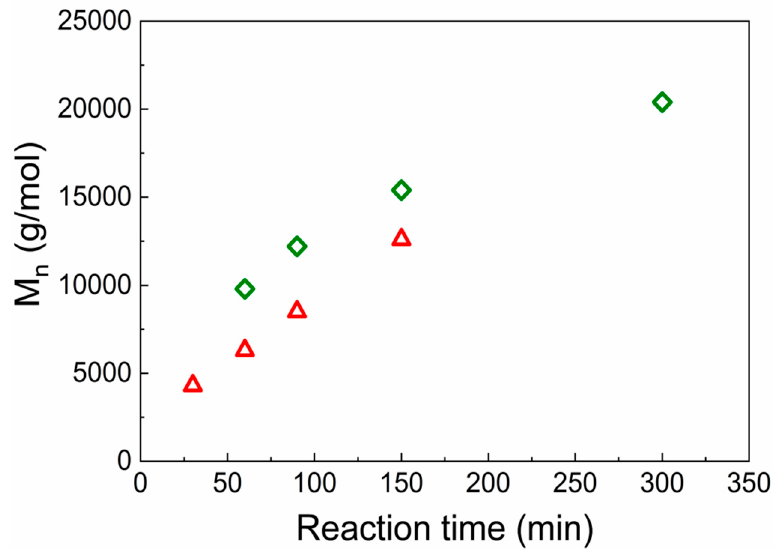
Figure 2. Evolution of the M n versus the time of preparation of GO-PHEMATMS − 1 ( ) and GO-PHEMATMS-2 ( ).